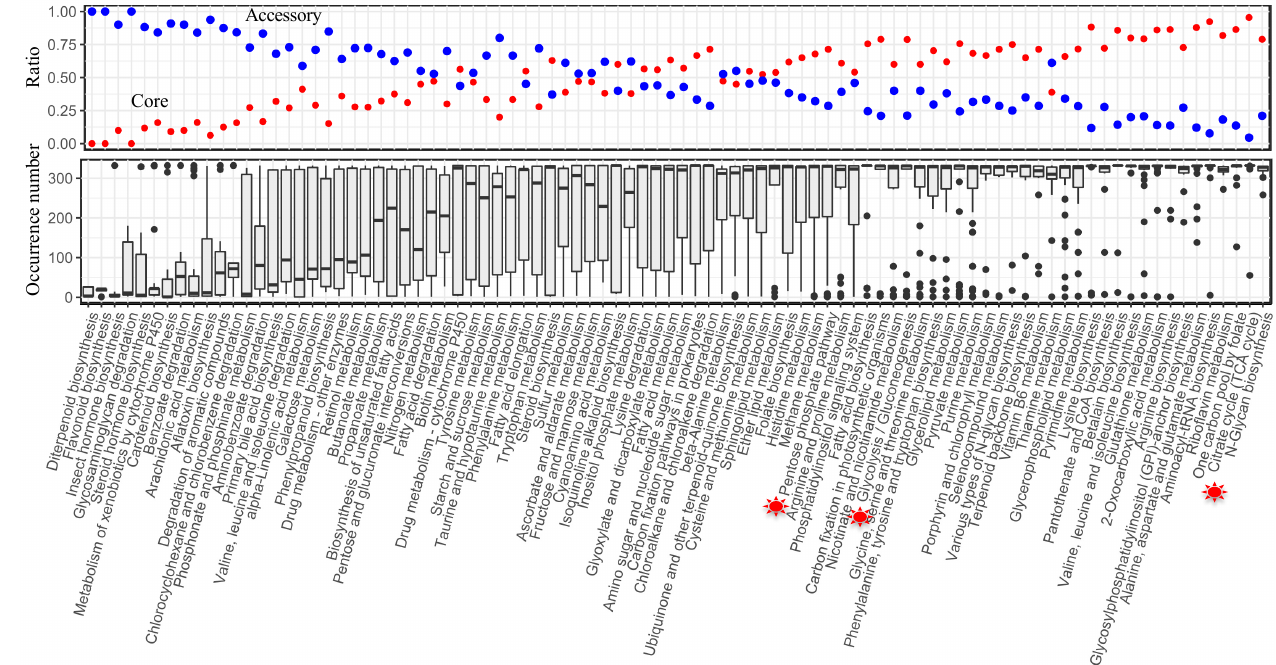
Figure 4. Analysis of the pan-draft metabolic model for 332 yeast species at the subsystem level. The subsystem definitions are from the KEGG database. The upper graph summarizes the ratio of core and accessory reactions in each subsystem and the lower graph summarizes the occurrence number of all reactions from each subsystem across 332 yeast species. The red and blue circle in upper graph dot represent the ratio of core and accessory reactions in each subsystem, respectively. The red symbols in the bottom graph represents the core metabolic pathways in yeast species, inclusing TCA cycle, EMP and PPP